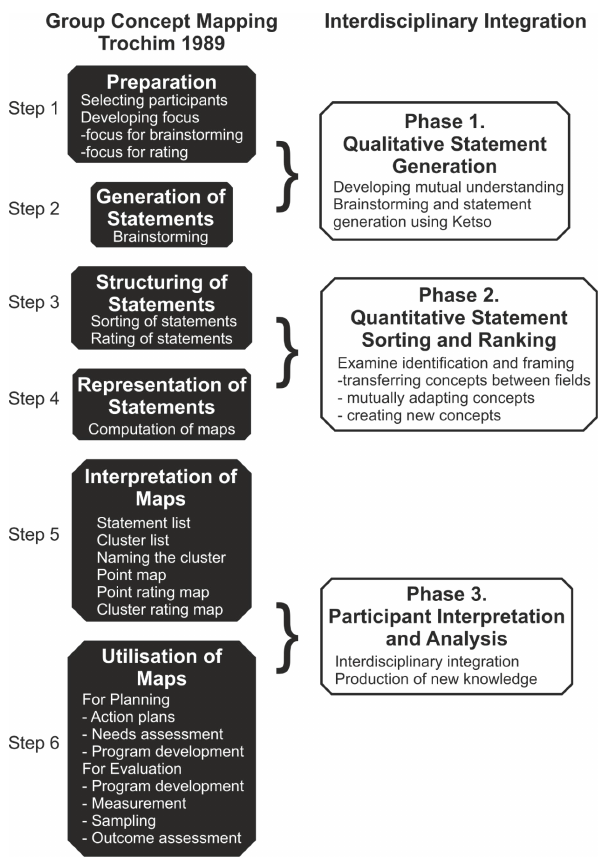
Figure 1. Group conceptual mapping (GCM) methodology with Ketso adapted from Trochim (1989) for interdisciplinary integra- tion.